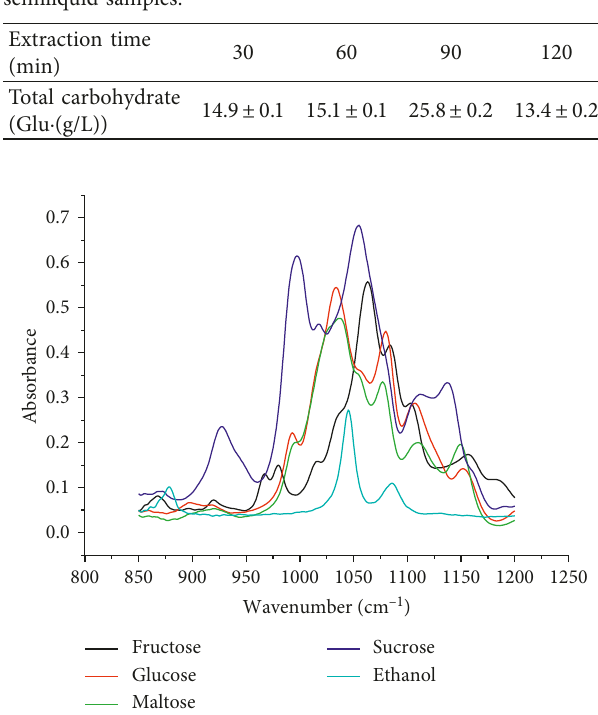
Figure 1: MIR spectra of 5% (w/w) ethanol and 10% (w/w) in- dividual sugars.